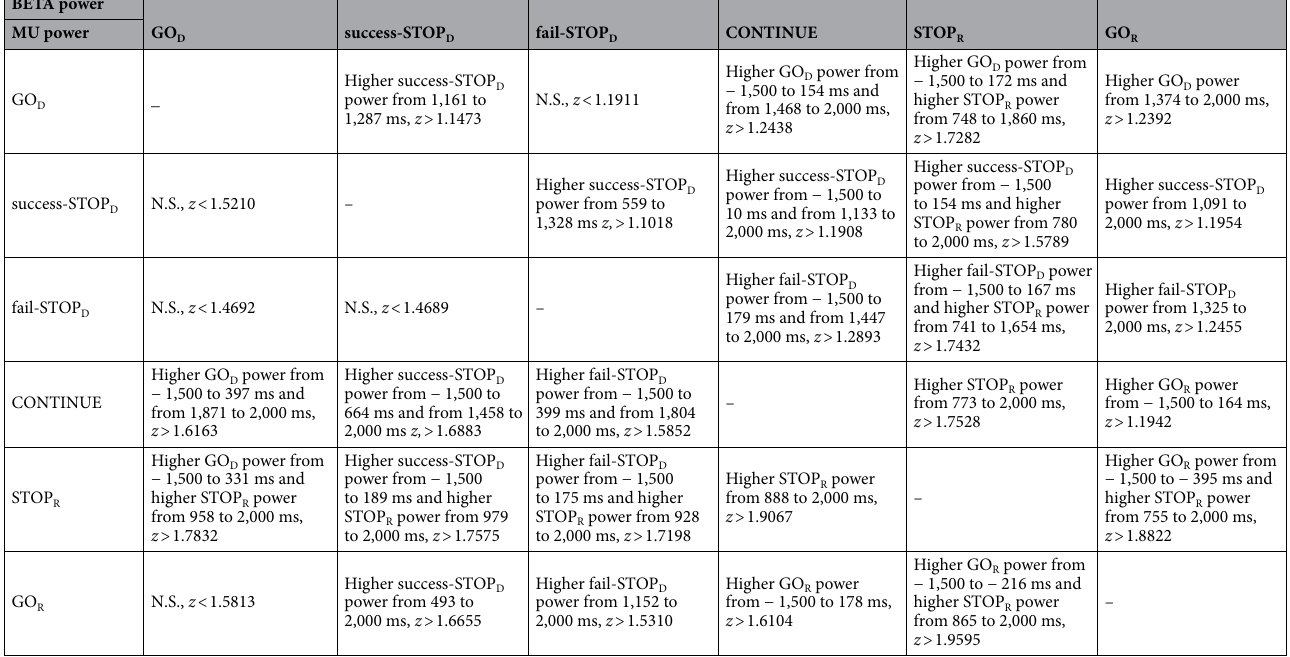
Table 1. Pairwise condition comparison of Mu and Beta power time series. Mu and Beta power time series from the clustered ICs were compared between experimental conditions in a pairwise fashion using a non- parametric permutation procedure (see “Method” section). The resulting time-ranges of significant difference between conditions are reported. Z values indicate the threshold values corresponding to P < .05 (corrected for multiple comparisons, see “Method”) retained to assess significance. N.S.